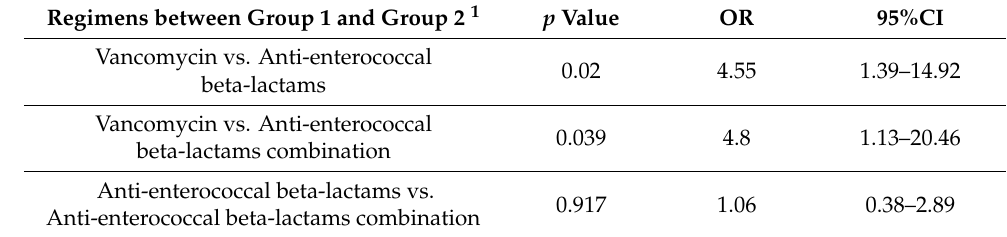
Table 3. Thirty-day mortality rate between antibiotic regimens to treat patients with ampicillin susceptible enterococci bloodstream